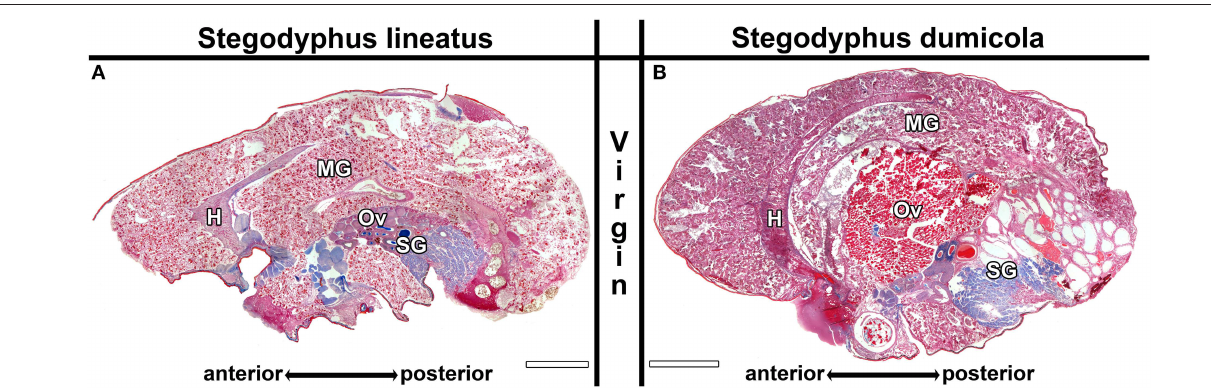
event in case the first brood is lost (Ricklefs and Wikelski,